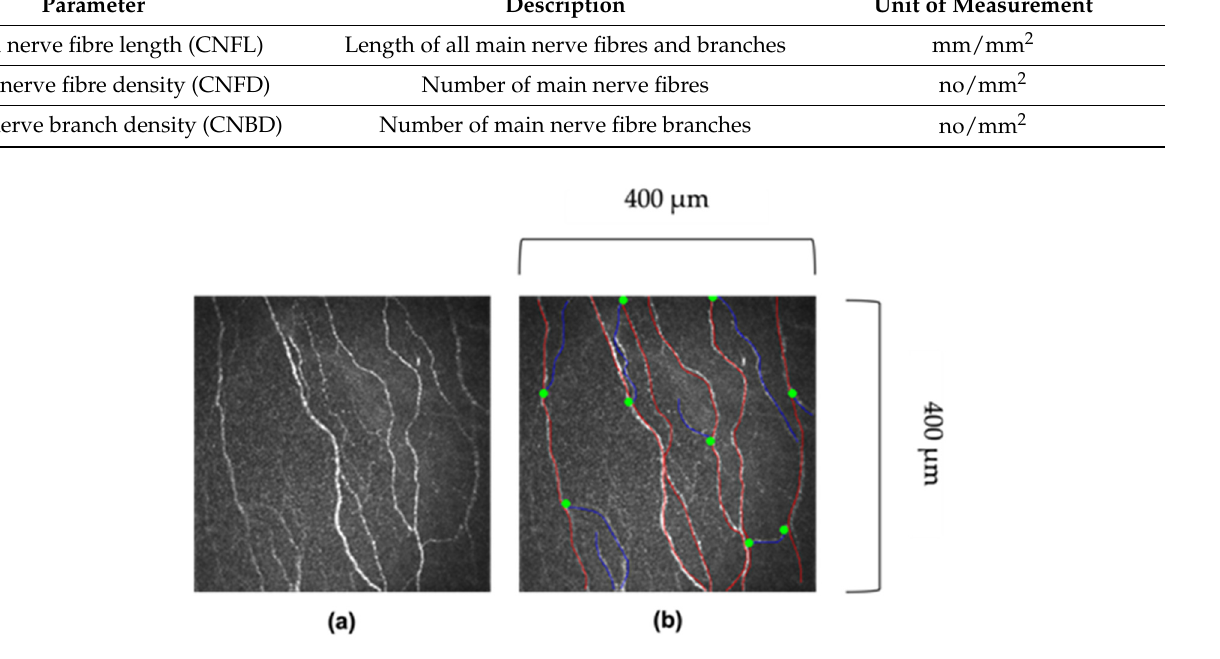
Figure 1. Images of corneal nerves. ( a ) Original image. ( b ) Red lines indicate the main corneal fibre, and blue lines indicate the corneal nerve branch. The greet dot indicates where the branch bifurcates off the main fibre. Images 400 μ m × 400 μ m.